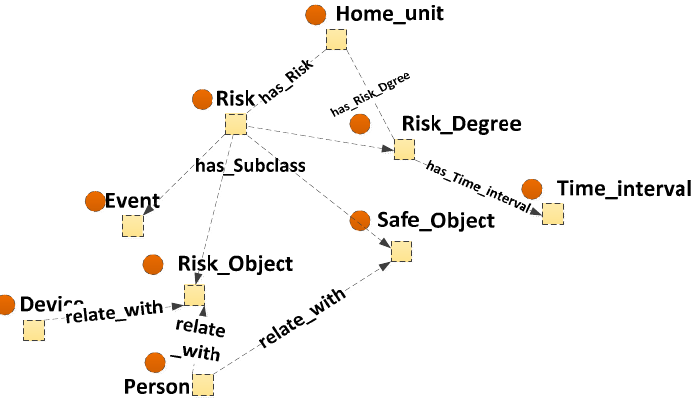
Figure 7. Ontology view focusing on risk knowledge. Table 2. Some properties’ relationships between relevant classes from a risk context